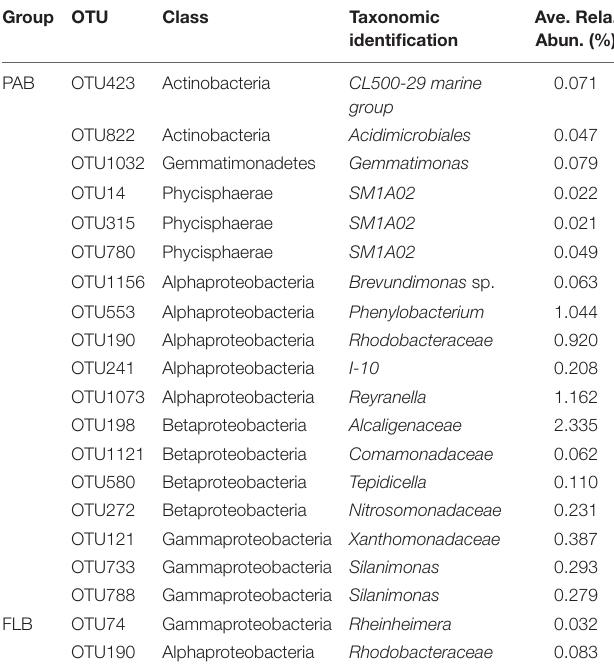
TABLE 5 | Classification and relative abundance of nodes connected to OTU359 (bloom-causing M. aeruginosa ). Group